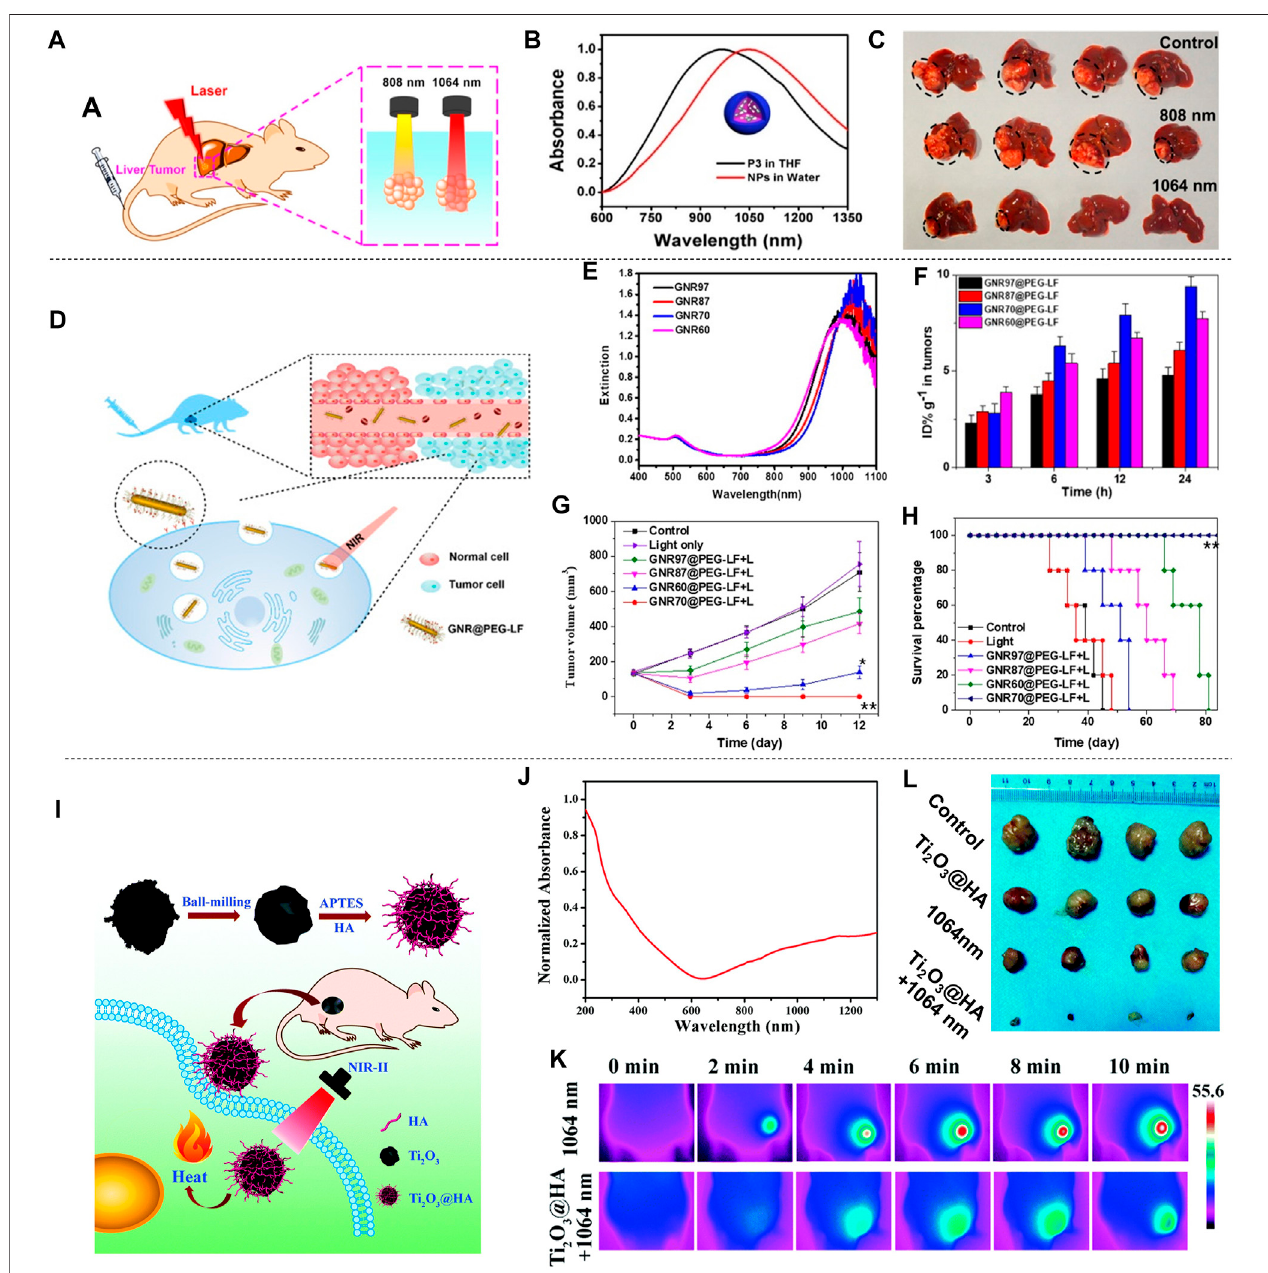
FIGURE 10 | Photothermal treatment of liver cancer. (A) Schematic diagram of PTT of liver cancer in situ with SPNs under 808 or 1,064 nm laser irradiation. (B) Absorption spectra of four semiconducting polymers (P1-P4) in THF. (C) Photograph of liver of tumor-bearing mice resected 17 days after treatment. Black circles indicate tumors in the liver (reproduced from (Sun et al., 2019) with permission from American Chemical Society). (D) Schematic diagram of the distribution of GNR@ PEG-LF in vivo and its use in photothermal treatment of cancer. (E) UV-vis-NIR spectra of GNRs@CTAB with different widths and lengths. (F) Histogram of the concentration of GNR@PEG-LF in tumors. (G) Tumor growth inhibition curves in mice injected with different GNRs and irradiated with 980 nm light (0.5 W cm − 2 ) for 3 min. (H) The Kaplan-Meier graph shows the percentage of animals surviving the study over time (reproduced from (Yang et al., 2020) with permission from Academic Press Inc.). (I) Schematic diagram of the preparation of Ti 2 O 3 @HA and its PTT for super fi cial tumors. (J) Absorption spectrum of Ti 2 O 3 @HA nanoparticles in PBS. (K) Infrared thermal image of HepG-2 tumor-bearing mice injected with PBS or Ti 2 O 3 @HA nanoparticles and irradiated with a 1064 nm laser (5 min at a power density of 1.0 W cm − 2 ). (L) Tumor images of each group after 14 days of different treatments (reproduced from (Zeng et al., 2018) with permission from Royal Society of Chemistry).